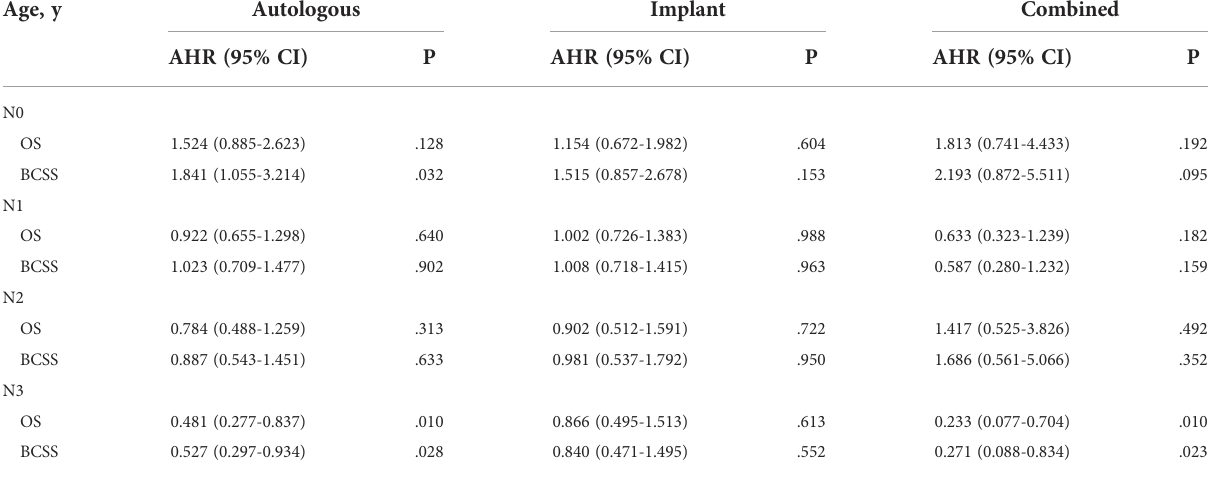
TABLE 4 Adjusted hazard ratio for OS and BCSS associated with radiotherapy after different reconstruction methods in patients with different AJCC_N stages. Age, y Autologous Implant